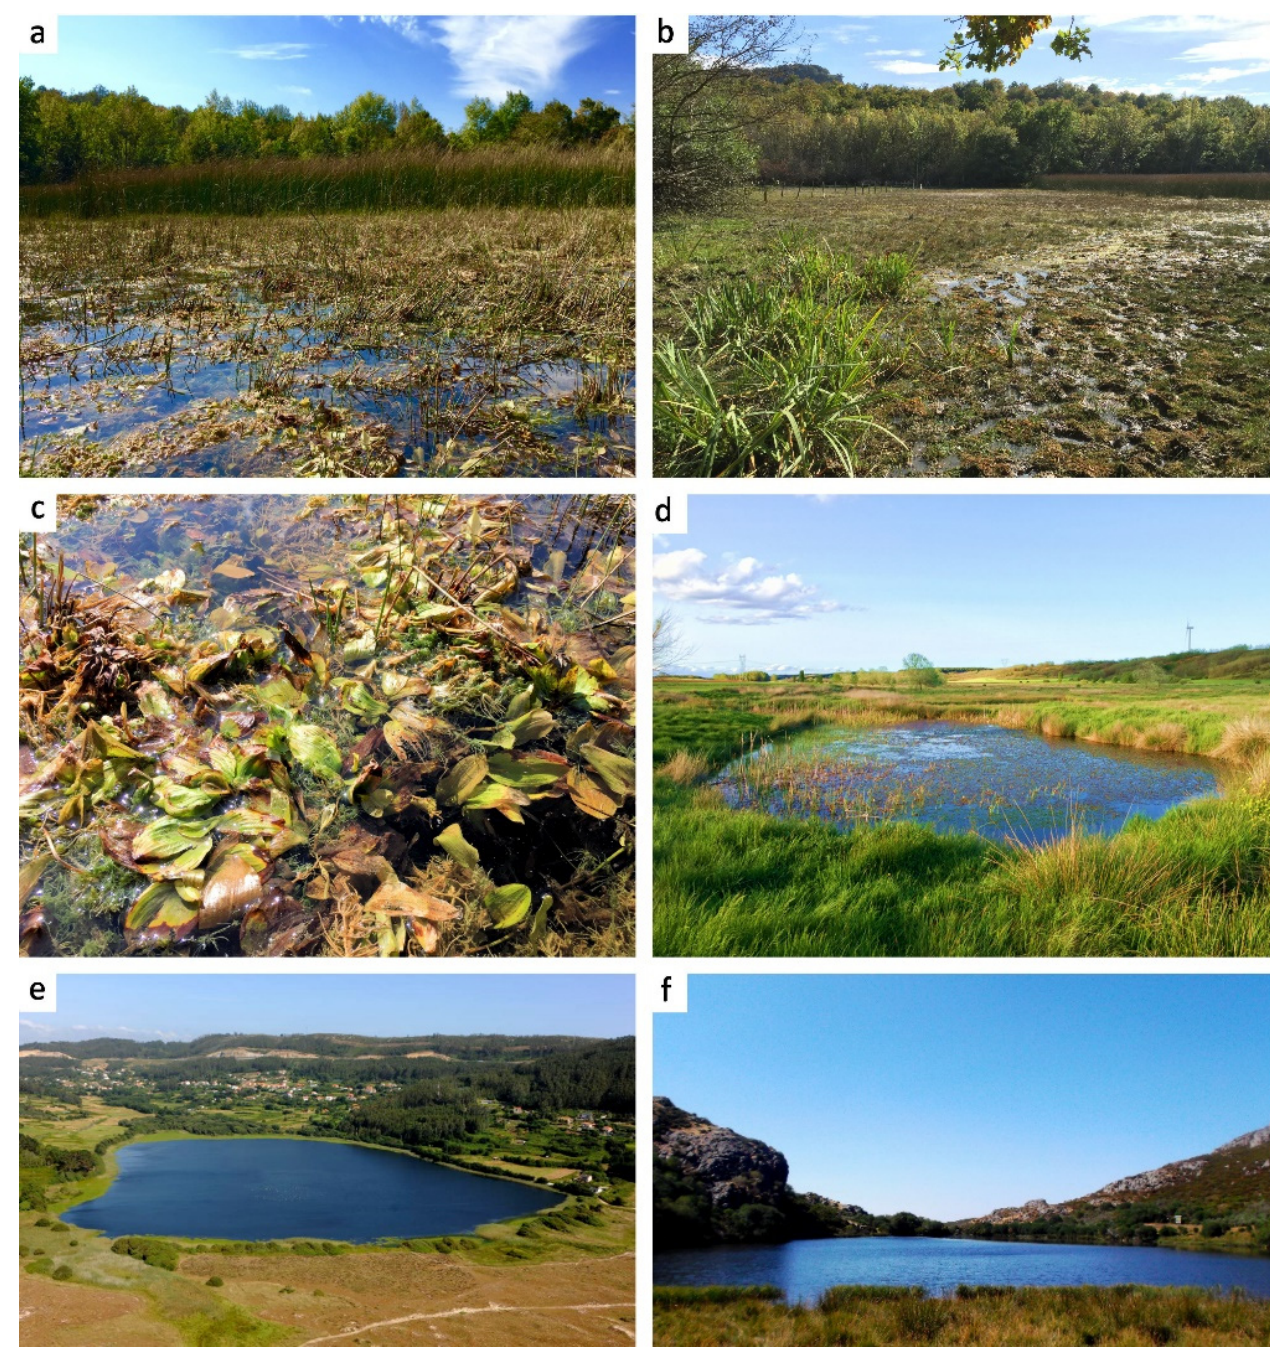
Figure 8. Habitats of Hirudo verbana in Spain. ( a , b ) Bikuña pond (Basque Country), type locality of H. verbana bilineata ssp. nov.; ( c ) detailed view of the same showing the Chara-Potamogeton association; ( d ) Cueza pond (León); ( e ) Doniños Lake (Galicia); ( f ) Ocelo lake (Galicia).